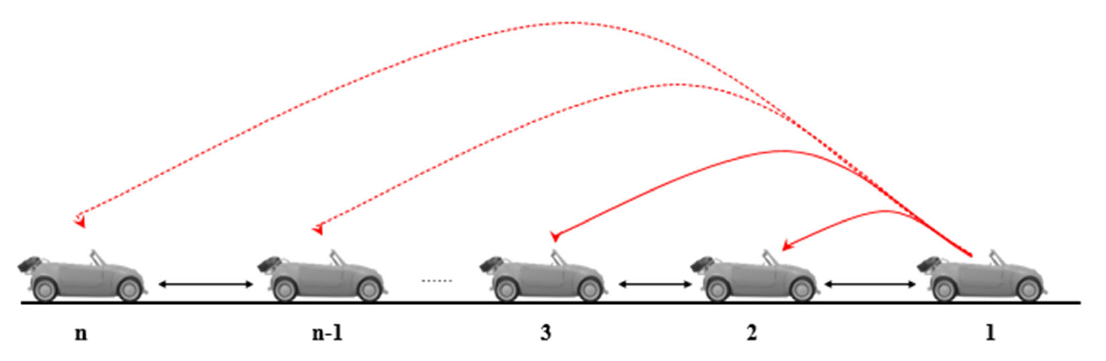
Figure 4. CACC control law to perform platoons